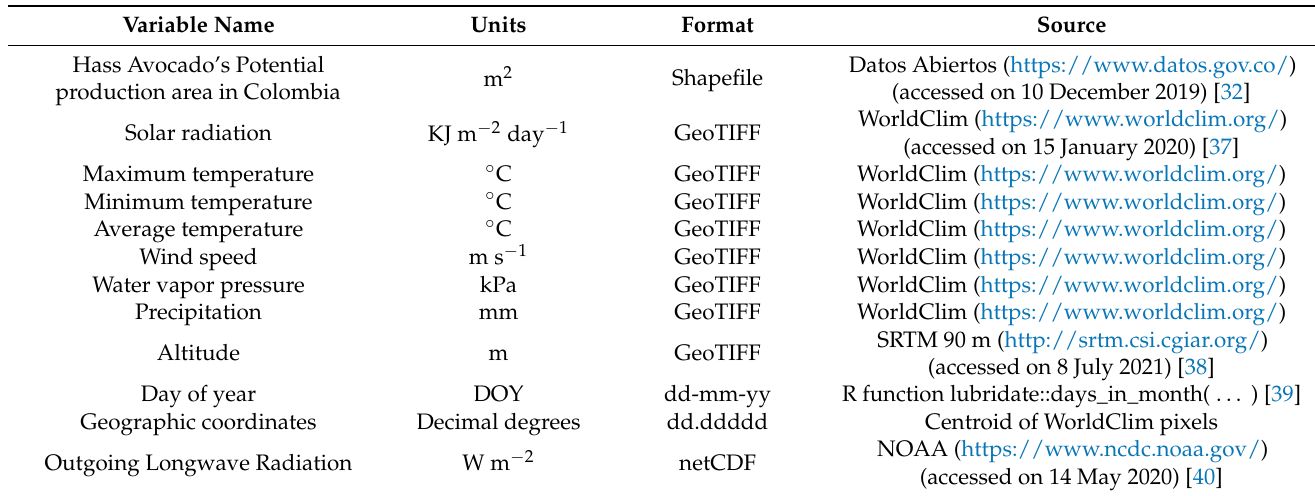
Table 1 for the period 1970–2000. Shuttle Radar Topography Mission SRTM 90 m GeoTIFF raster pixels have the above-sea-level altitude. The pixel resolution of WorldClim and SRTM 90 m is 1 km 2 and 8100 m 2 , respectively. For monthly estimates of ETo , the day of the year represents the 15th day of each month. Geographic coordinates were taken from the centroid of WorldClim pixels. The coordinate reference system of all spatial data was WGS84. The Outgoing Longwave Radiation data were arranged in a 3D array represented by the notation L ( i , j , k ) , where i , j are the longitude and latitude (decimal degrees), and k is the time (month), respectively. The spatial resolution of L ( k ) is 2.5 ◦ × 2.5 ◦ [36]. Table 1. Description of variables used in the